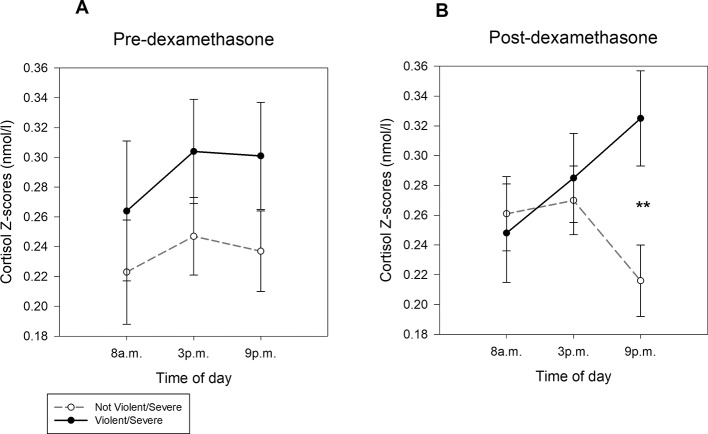
Cortisol levels (mean ± SEM of Z-scores) at 8a.m., 3p.m. and 9p.m. A) before and B) after oral administration of dexamethasone in saliva samples from violent/serious suicide attempters and non-violent/serious suicide attempters. **p < .010.